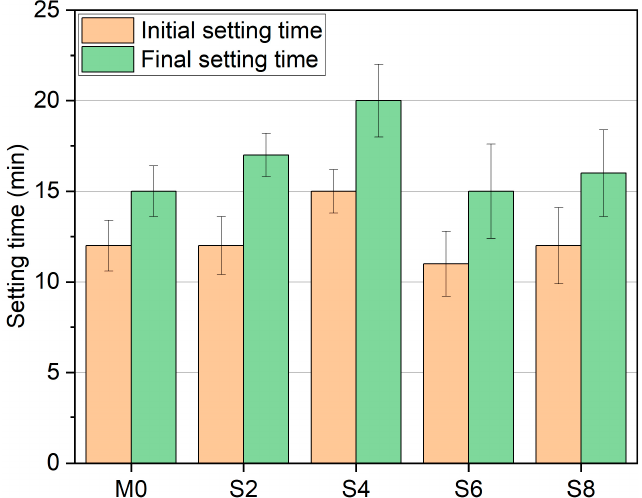
Figure 3. Effect of sucrose on AAS setting time under different dosages. Figure 3. E ff ect of sucrose on AAS se tt ing time under di ff erent dosages.